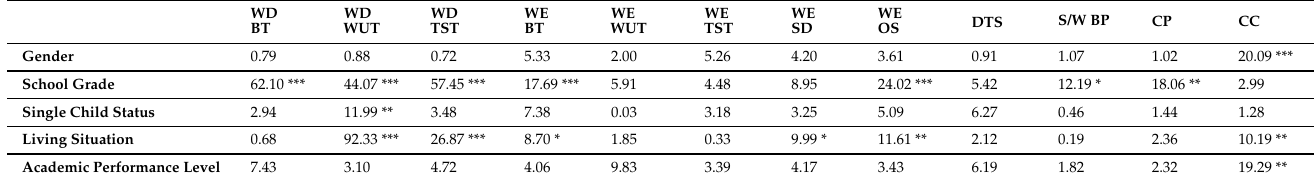
Table 2. Results of the multipair Kruskal–Wallis tests with sleep dimensions as dependent variables and demographic information as single factors. Sleep dimensions of interest were weekday bedtime (WD BT), weekday wake up time (WD WUT), weekday total sleep time (WD TST), weekend bedtime